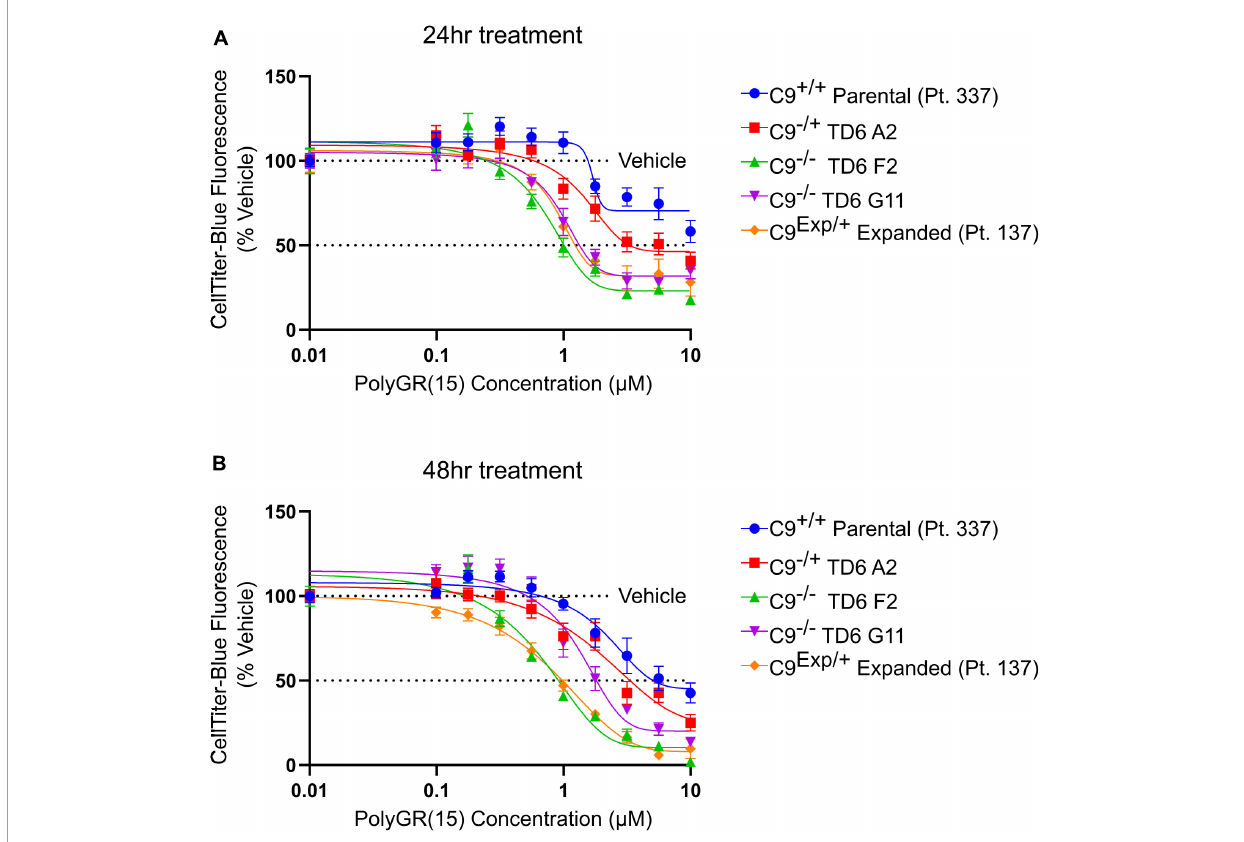
FIGURE3 Reduced C9orf72 expression exacerbates polyGR 15 toxicity in induced pluripotent stem cell (iPSC)-derived motor neurons. (A) Neuronal survival 24 h after exogenous treatment with polyGR 15 ranging from 10 nM to 10 µ M or 0.1% DMSO control. Values were normalized to vehicle treated wells for each cell line. (B) Neuronal survival 48 h after exogenous treatment with polyGR 15 or 0.1% DMSO control. Values were normalized to vehicle treated wells for each cell line. Data are presented as mean values ± standard deviations (error